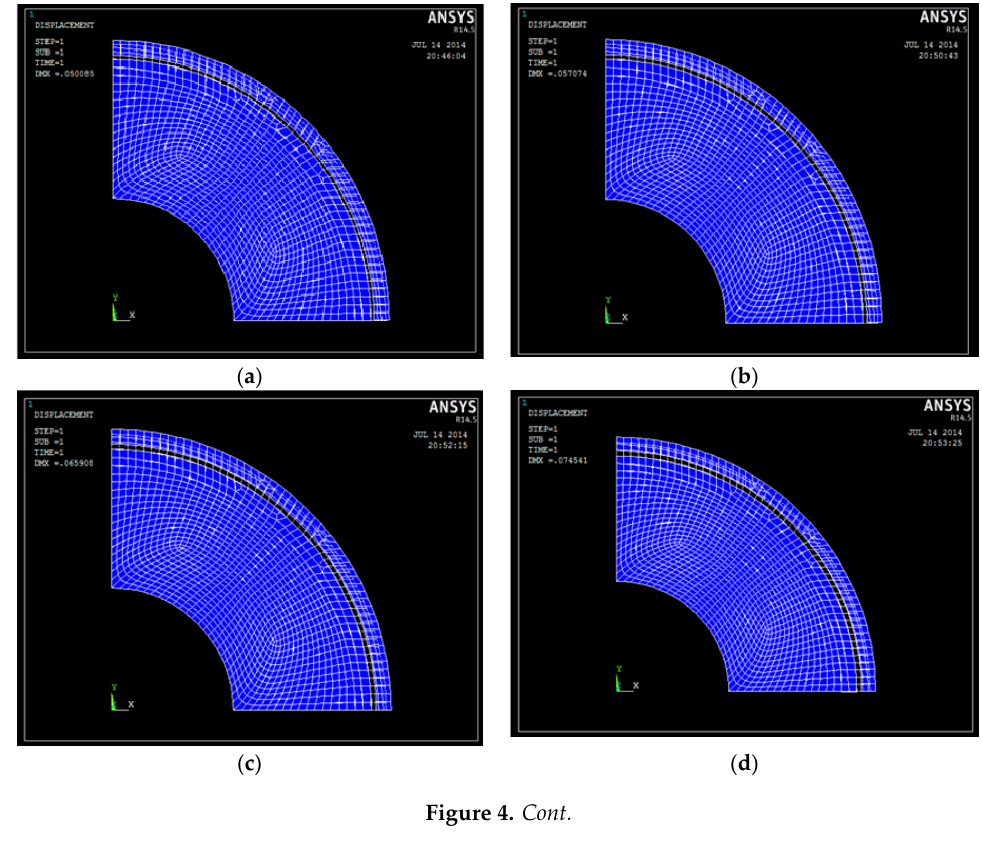
Table 2. Material performance